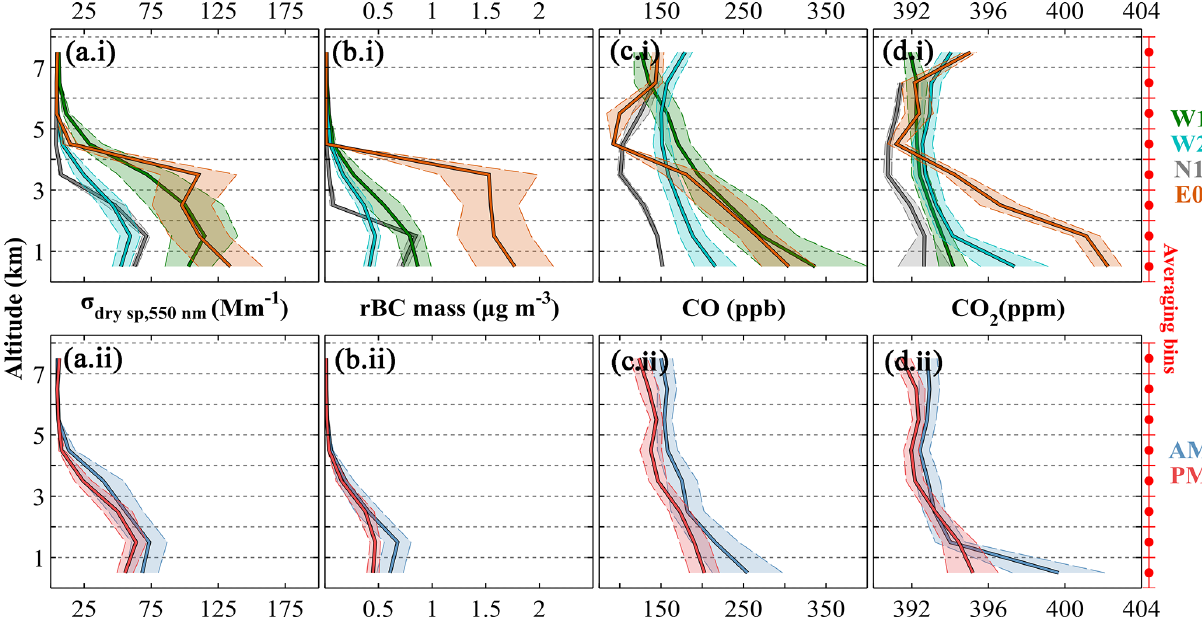
Figure 8. Median pollutant profiles averaged over the different regimes (a.i–d.i) and time of day ( a.ii–d.ii , includes data from all regimes). Lighter shading represents the median absolute deviation. Note that σ sp_dry is reported at standard temperature, standard pressure and 30% RH, and hence the column AOD cannot be derived from these